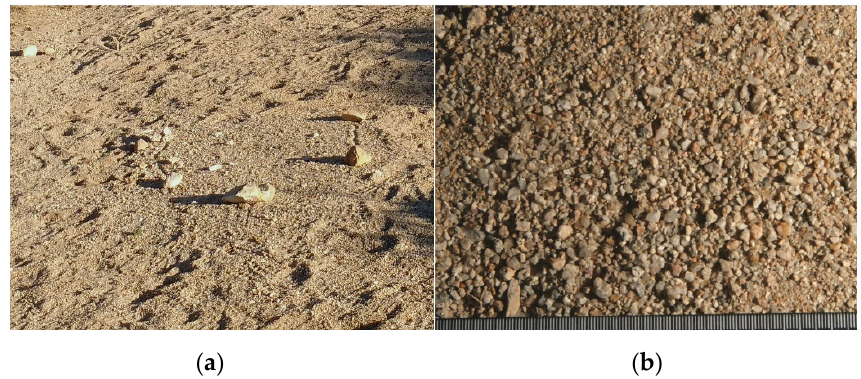
Figure 4. ( a ) Mountain Pass, CA, alluvial fan site as seen from a few meters distance in late afternoon. Latitude: N 35 degrees 22 min 2.273 s. Longitude W115 degrees 34 min 43.5 s. North is towards the bottom of the figure. The image is of a region approximately 3 m in extent. ( b ) Nadir view of laboratory recreated soil surface as measured at USGS, illuminated with a strobe light at about the same angle of incidence as the field image, scale in millimeters at bottom of photo. BRDF field measurements were made at about 05:00 UT, 28 September 2017.